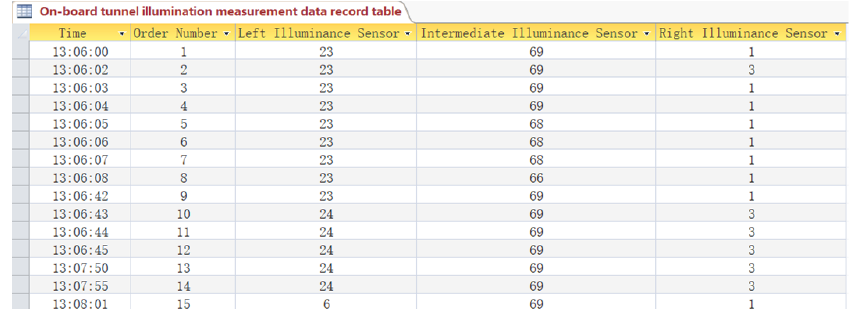
Figure 10. Access database interface at 13:00.